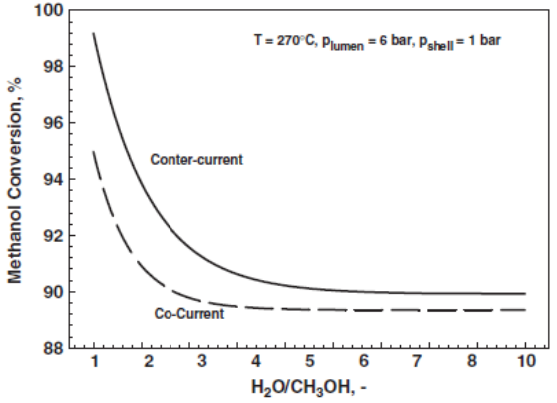
Figure 5. 1-D modelling of MSR reaction in a Pd-based MR: methanol conversion versus feed molar ratio. Figure 5. One-dimensional (1-D) modelling of MSR reaction in a Pd-based MR: methanol conversion With permission of reprint of Elsevier from Gallucci and Basile [52]. versus feed molar ratio. With permission of reprint of Elsevier from Gallucci and Basile